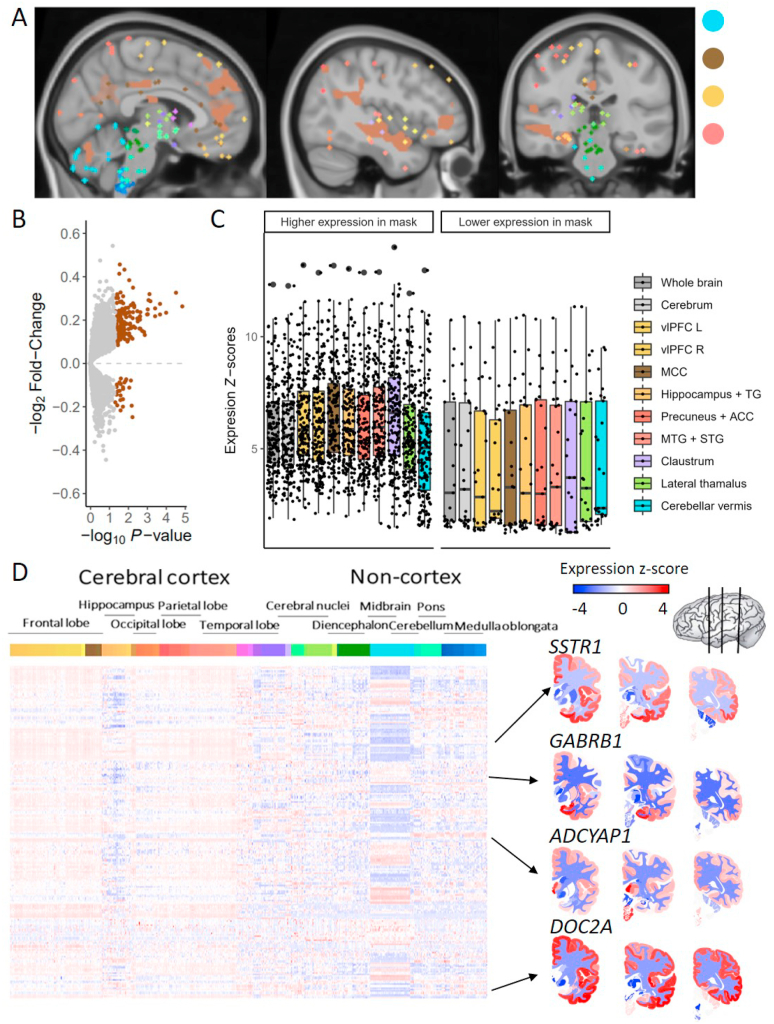
Differentially expressed genes in brain regions vulnerable to stress based on siblings of schizophrenia patients can be identified using gene expression atlases. (A) Brain regions in our stress network are present throughout the brain (including cerebellum, cingulate gyrus, frontal gyrus, temporal gyrus, and hippocampal formation). For the analysis, all regions in the cortex were combined. (B) Differential gene expression was determined for our cortical stress network compared to the rest of the cortex. Significant genes (BH-adjusted p-value < 0.05) have higher expression in our stress network. Grey dots represent non-significant genes and brown dots represent significant genes based on meta-analysis across all six AHBA donors. (C) The box plots show the expression of the higher (left) and lower (right) expressed genes compared to the rest of the cortex in the brain regions of interest from our stress network. (D) In the whole brain, differentially expressed genes show mostly high expression levels in the cortex and low expression levels in non-cortical brain regions. In the heatmap, each row represents a gene and each column represents a sample and all samples of the AHBA are illustrated here. On the right, coronal brain sections for the genes SSTR1, GABRB1, ADCYAP1, and DOC2A are presented. Colors indicates high (red) and low (blue) expression levels. (For interpretation of the references to colour in this figure legend, the reader is referred to the Web version of this article.)